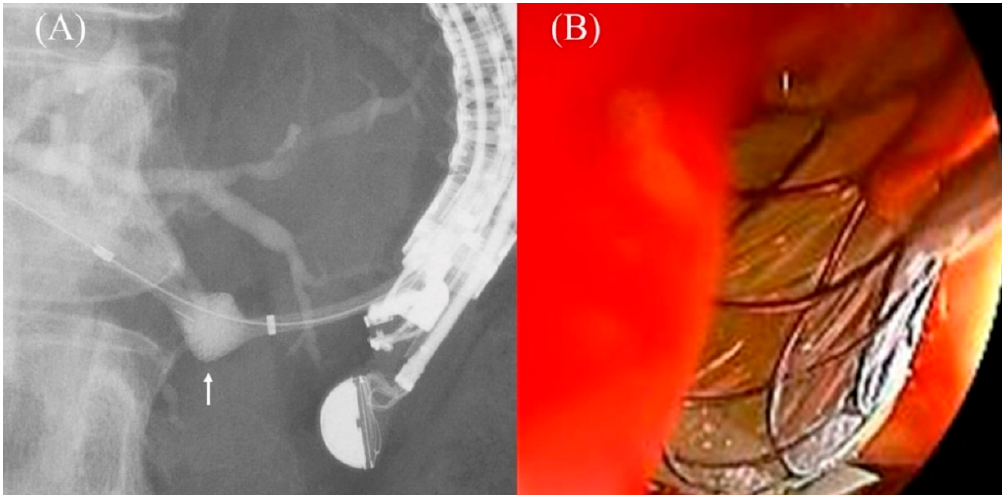
Figure 21. Intra-channel (conduit) release method. After pulling the introducer until 1 to 2 cm release inside the channel, push the expanded part of the stent (arrow) to strongly press the gastric wall for keeping the stomach and liver close together ( A ). Stent deployment across the gastric wall can be directly confirmed by endoscopic view ( B ).